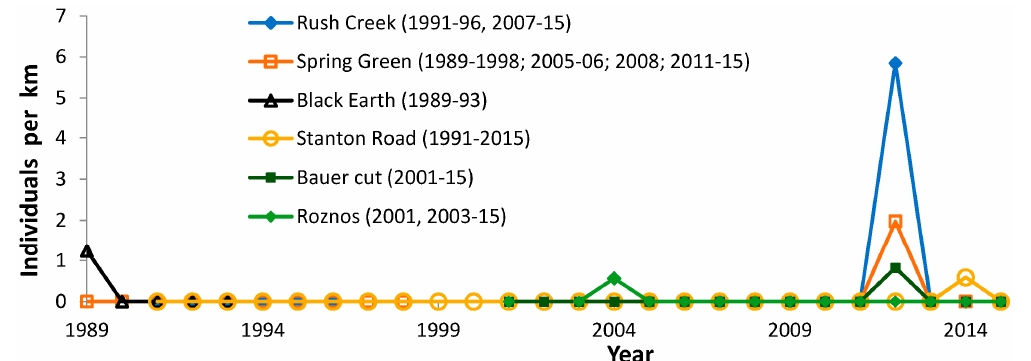
Figure 9. Regal fritillary individuals per km on peak survey per year at six sites with a record in only